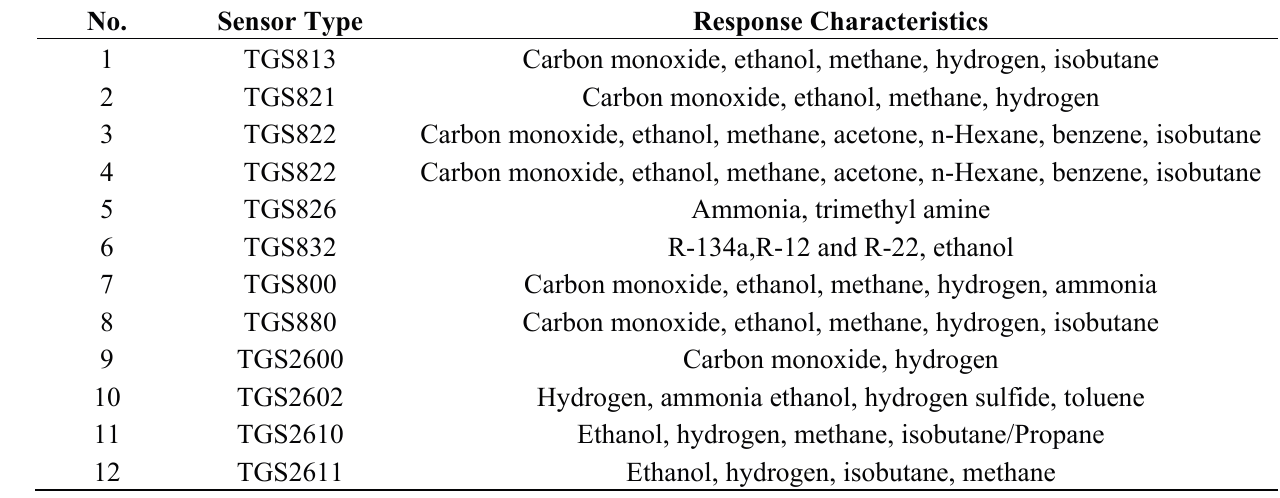
Figure 1. The schematic diagram of the E-nose system. Table 2. Response characteristics of the